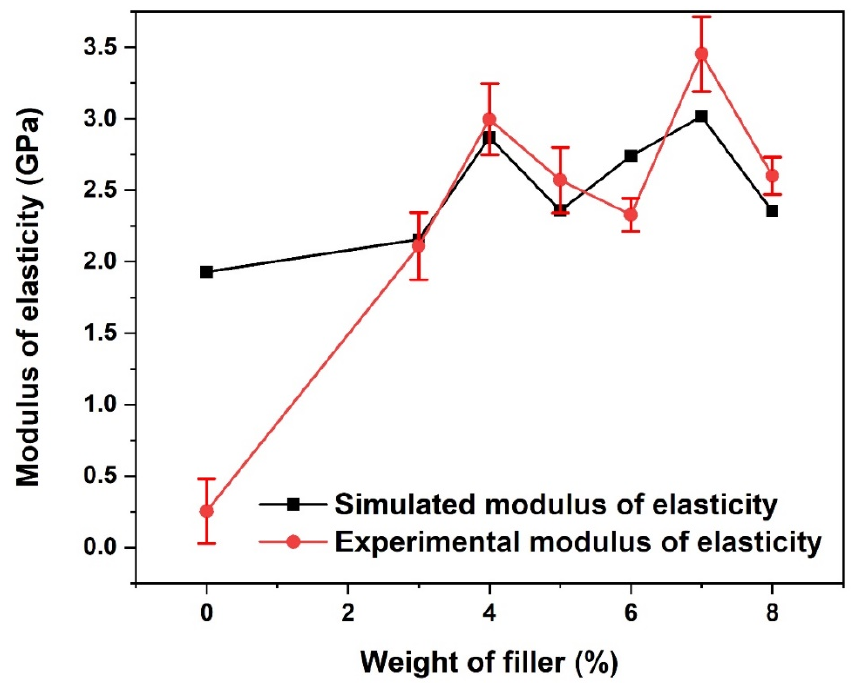
Materials 2022 , 15 , x FOR PEER REVIEW Figure 8. Young modulus of PLA-coconut fibre reinforced composite. Figure 8. Young modulus of PLA-coconut fibre reinforced composite.